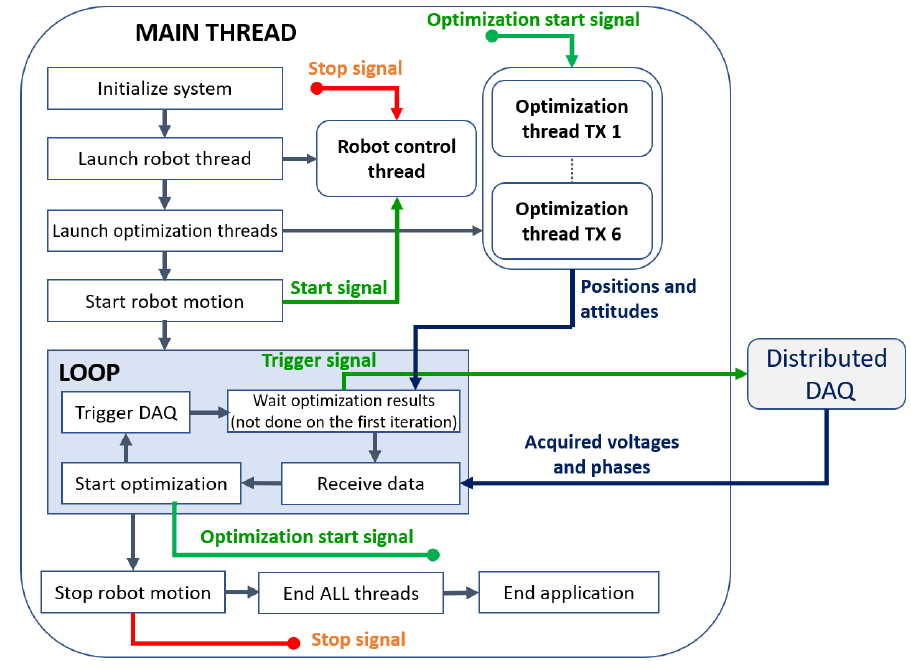
Figure 7. Simplified flow chart of the control